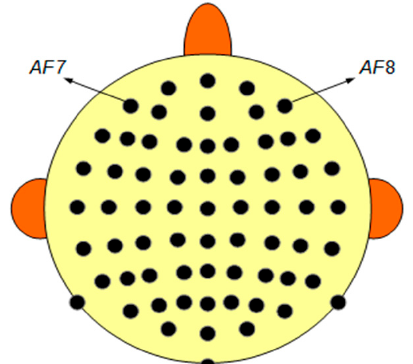
Figure 1. Distribution of the electrodes on the scalp. AF7 and AF8 are the electrodes of the signals used in the graphical representations.